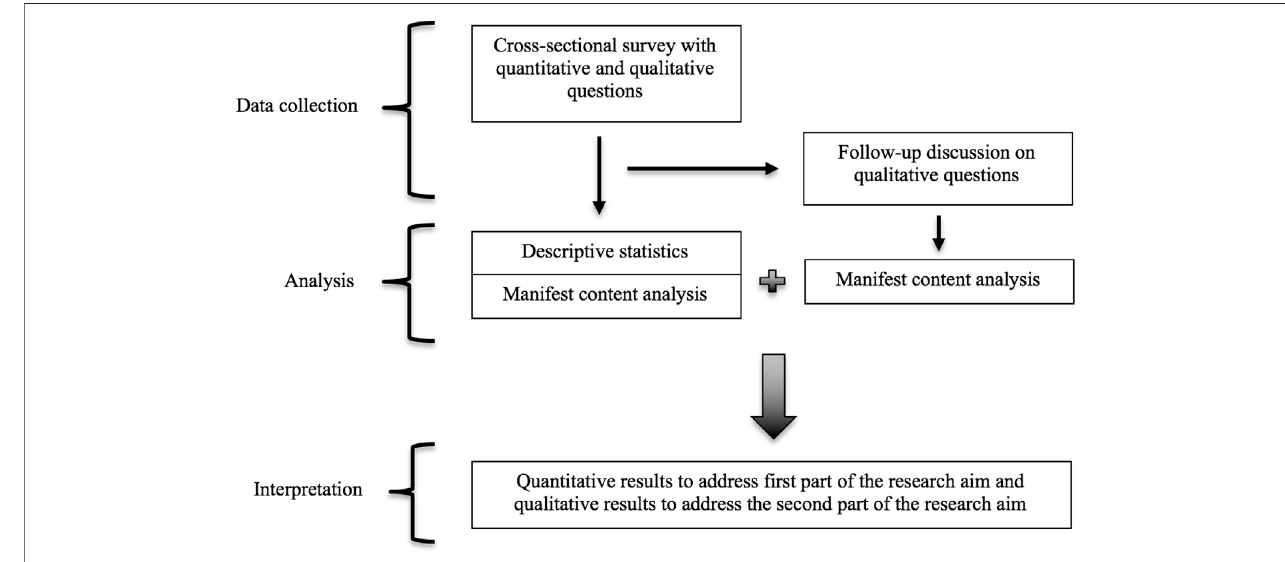
FIGURE 1 | Visual representation of the study design steps for data collection, analysis and